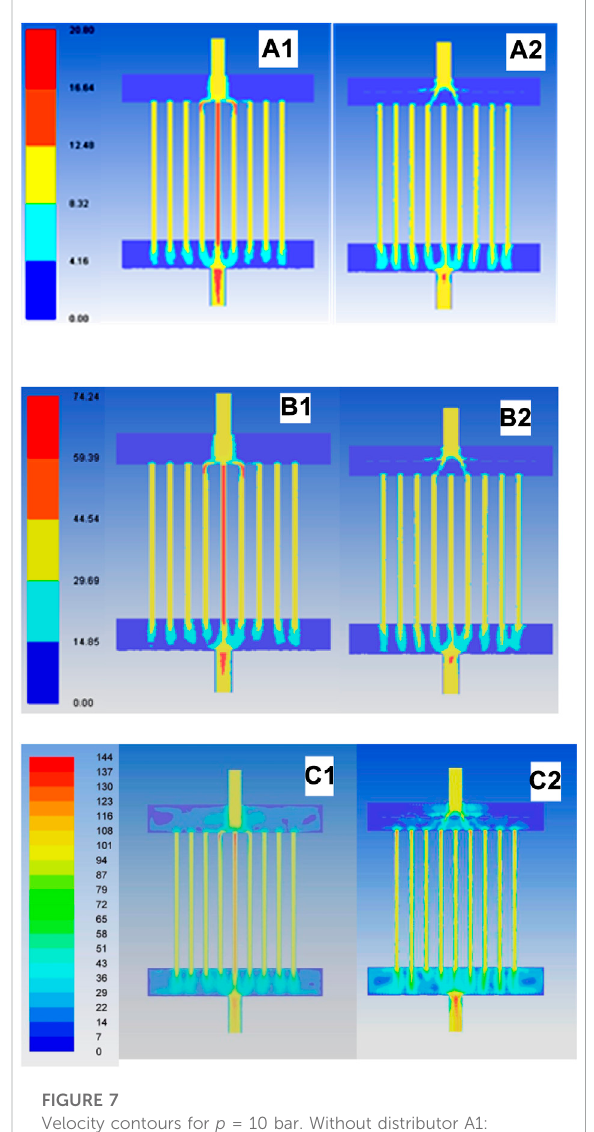
FIGURE 7 Velocity contours for p = 10 bar. Without distributor A1: Reynolds number (Re) = 2.82E+05; B1: Re = 9.86E+05; C1: Re = 1.91E+06. With distributor A2: Re = 2.82E+05; B2: Re = 9.86E+05; C2:Re=1.91E+06(allunitsofvelocityaregiveninm/sforthe color legend). FIGURE 8